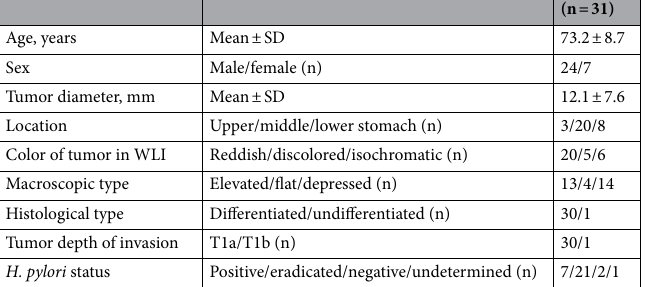
Table 1. Characteristics of the patients with EGC. SD Standard deviation, WLI White-light imaging.